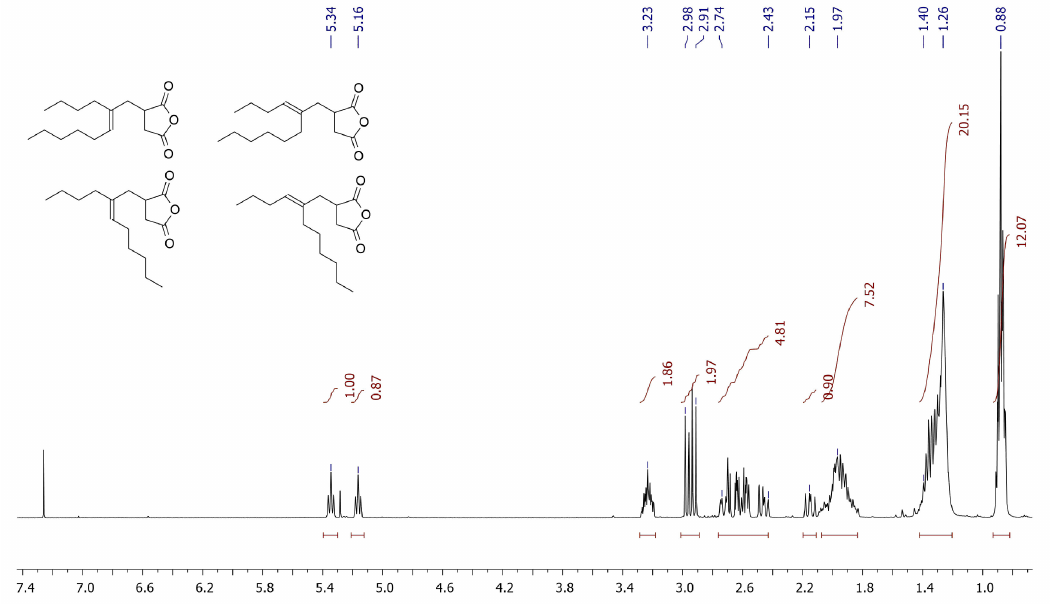
Figure 3. 1 H NMR spectrum (CDCl 3 , 20 ◦ C, 400 MHz) of the products of the Alder-ene reaction between MA and 5-methyleneundecane. Volatile product of the isomerization of the starting olefin and MA were preliminarily eliminated at 0.01 Torr and 100 ◦ C.